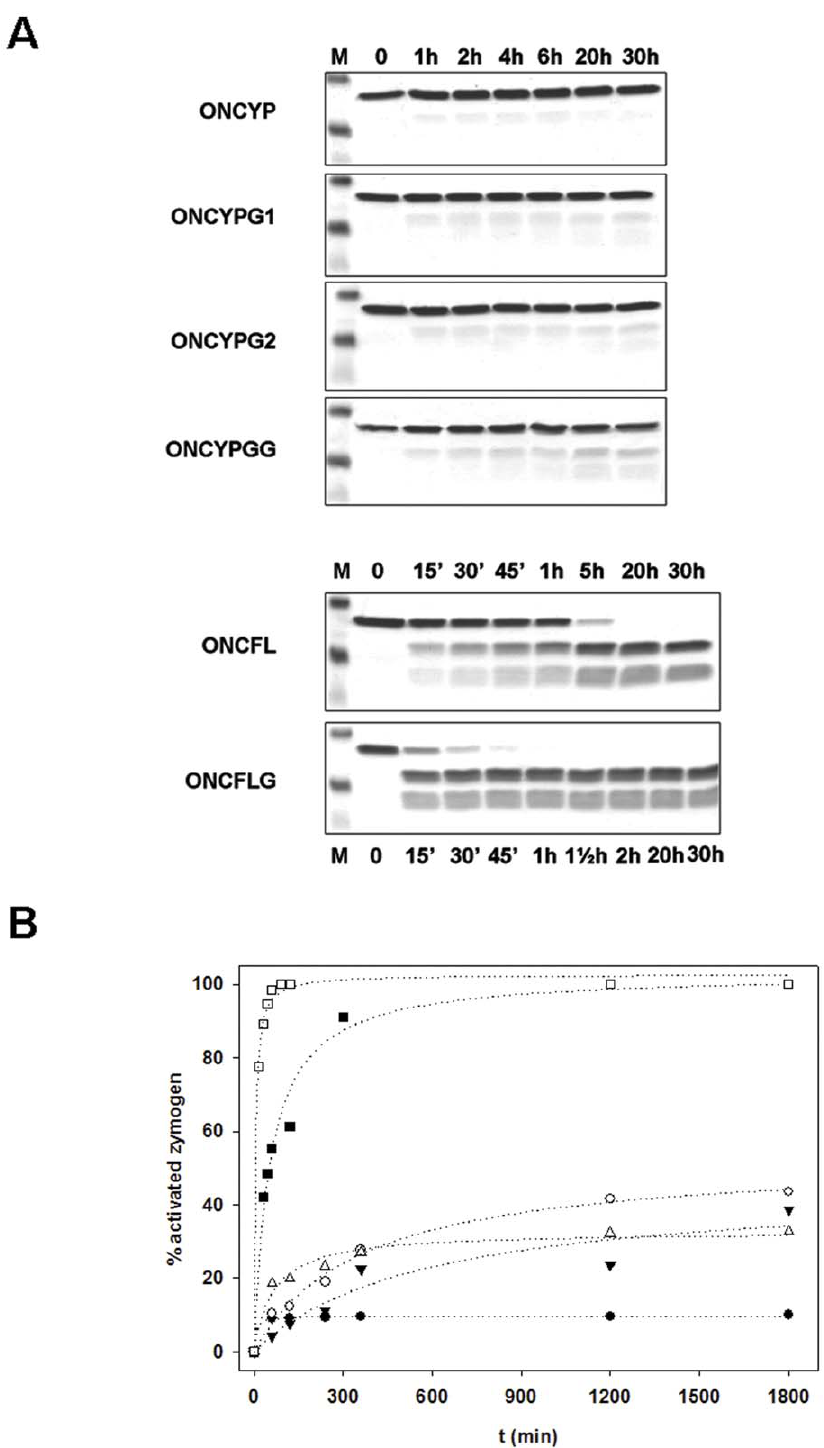
Figure 2. Cleavage of circularly permuted ONC variants by HIV-1 protease. (A) Cleavage measured at different times after addition of HIV-1 protease at a molar ratio (protease:variant) of 1:5 for YP and 1:100 for FL variants and analysis by Coomasie-stained SDS-PAGE under reducing conditions. For all the gels, lane M corresponds to molecular mass standards: 15, 10 and 4 kDa. For variants ONCYP, ONCYPG1, ONCYPG2 and ONCYPGG, lanes 1 to 7 correspond to samples taken 0, 1, 2, 4, 6, 20 and 30 h after protease addition. For ONCFL (lanes 1–8), samples were taken at 0 min, 15 min, 30 min, 45 min, 1 h, 5 h, 20 h and 30 h and for ONCFLG (lanes 1–8), at 0 min, 15 min, 30 min, 45 min, 1 h, 1.30 h, 2 h, 20 h and 30 h. N (B) Time-course of the activation of the different variants followed by quantification of the disappearance of the variant band using the Imaging ); ONCYPG1 ( . ); ONCYPG2 ( = ); ONCYPGG ( # ); ONCFL ( & ); System FluorChem H SP (Alpha Innotech, San Leandro, CA, USA). Legends: ONCYP ( ONCFLG ( % ).